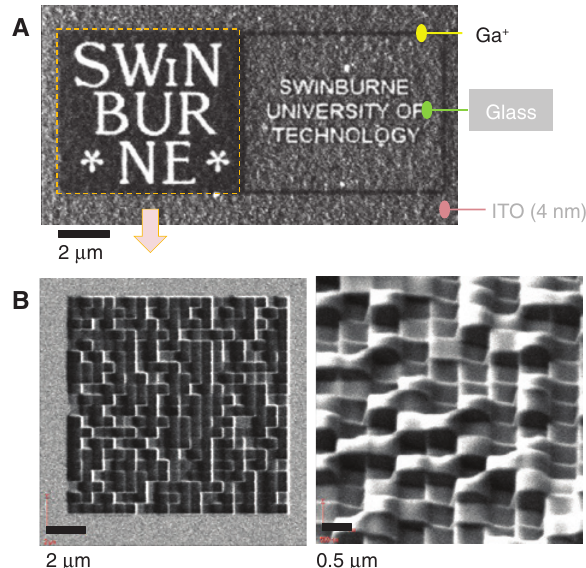
Figure 6: SEM images. (A) Ga + FIB milling of indium tin oxide (ITO) layer coated on a glass substrate: implantation (darker regions) and material removal (white). (B) An FIB-milled phase plate (at different magnification and view angle) of a hologram to project the left half section of the logo image above (marked by a dashed square); courtesy Gervinskas